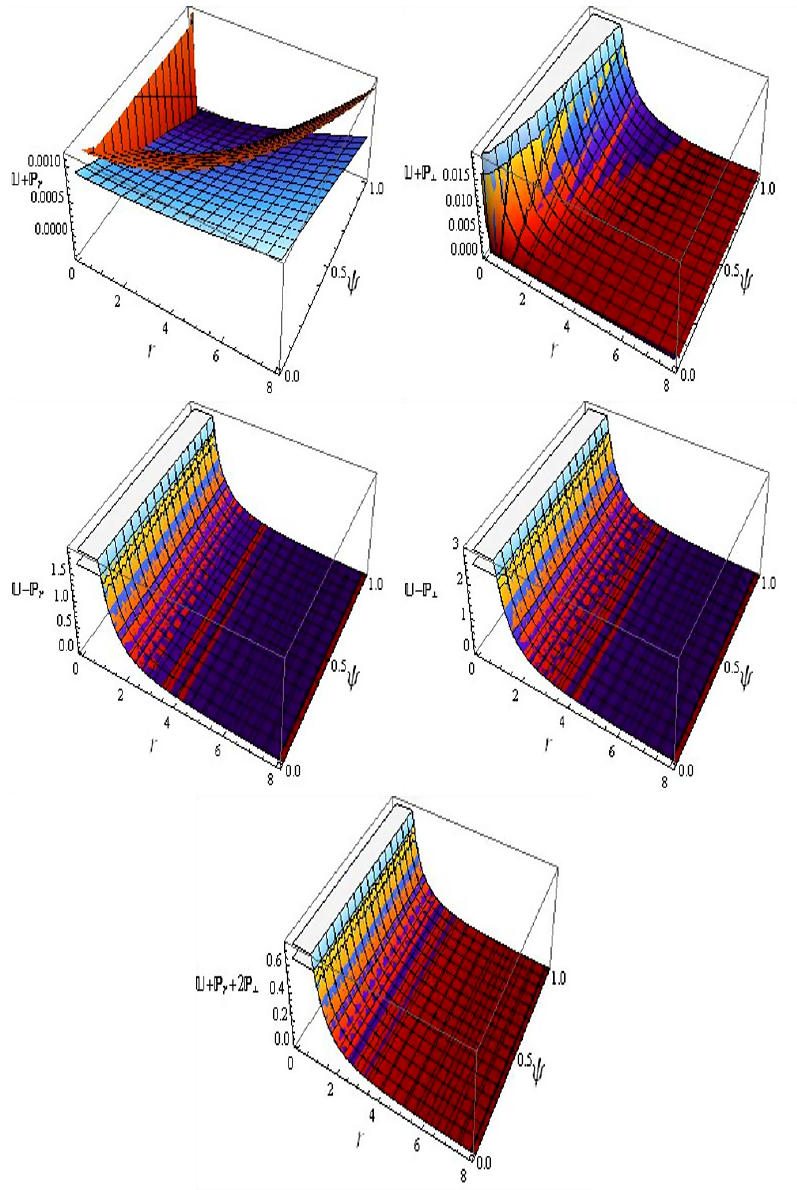
Figure 5. Plots of energy constraints versus ψ and r corresponding to two stellar candidates (Solution II).